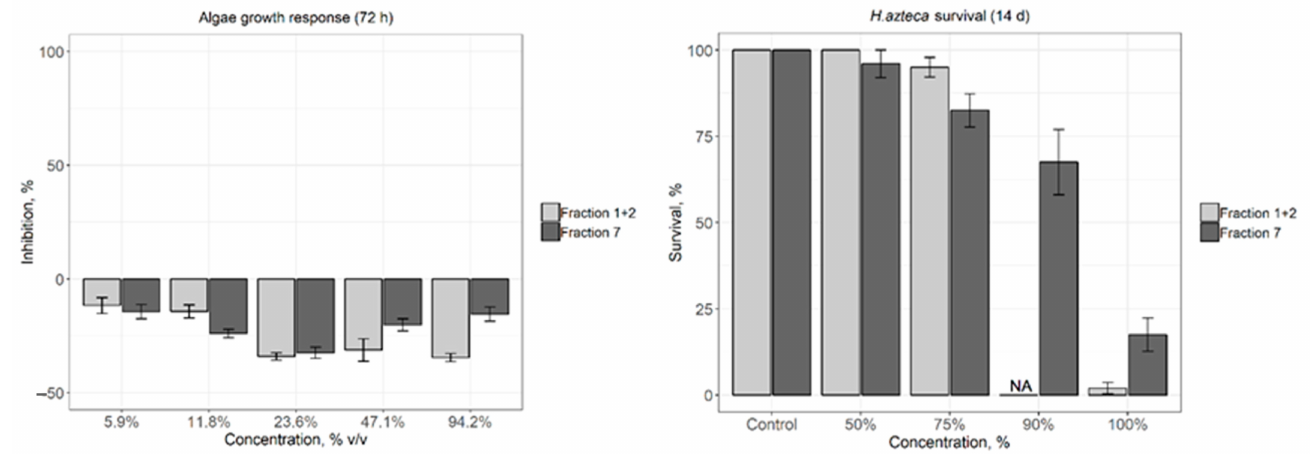
Figure 5. Algae growth response after 72 h (optical density measurements at 680 nm, left ), Hyalella. azteca survival after 14 days ( right ). (NA: not analyzed,